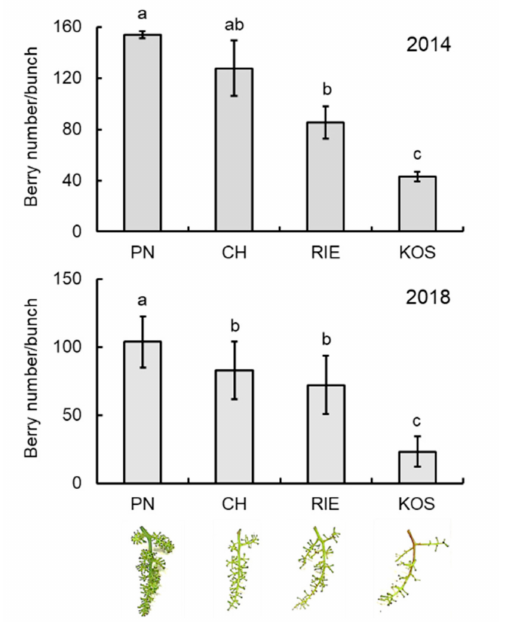
Figure 1. Number of berries per bunch. Bunches were collected in the 2014 and 2018 growing seasons. Bars indicate means ± standard deviations of ten bunches. Di ff erent letters above the columns indicate statistically significant di ff erence ( p < 0.05, Dunnett’s test). PN, Pinot Noir. CH, Chardonnay. RIE, Riesling. KOS, Koshu. Phenotypes of inflorescence are indicated below the graph.